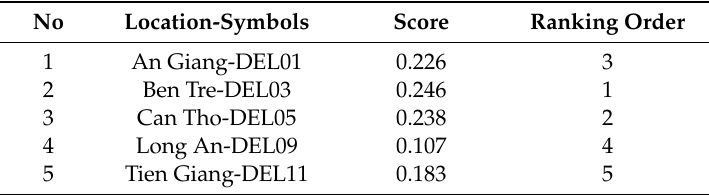
Table 9. Final ranking from the FANP